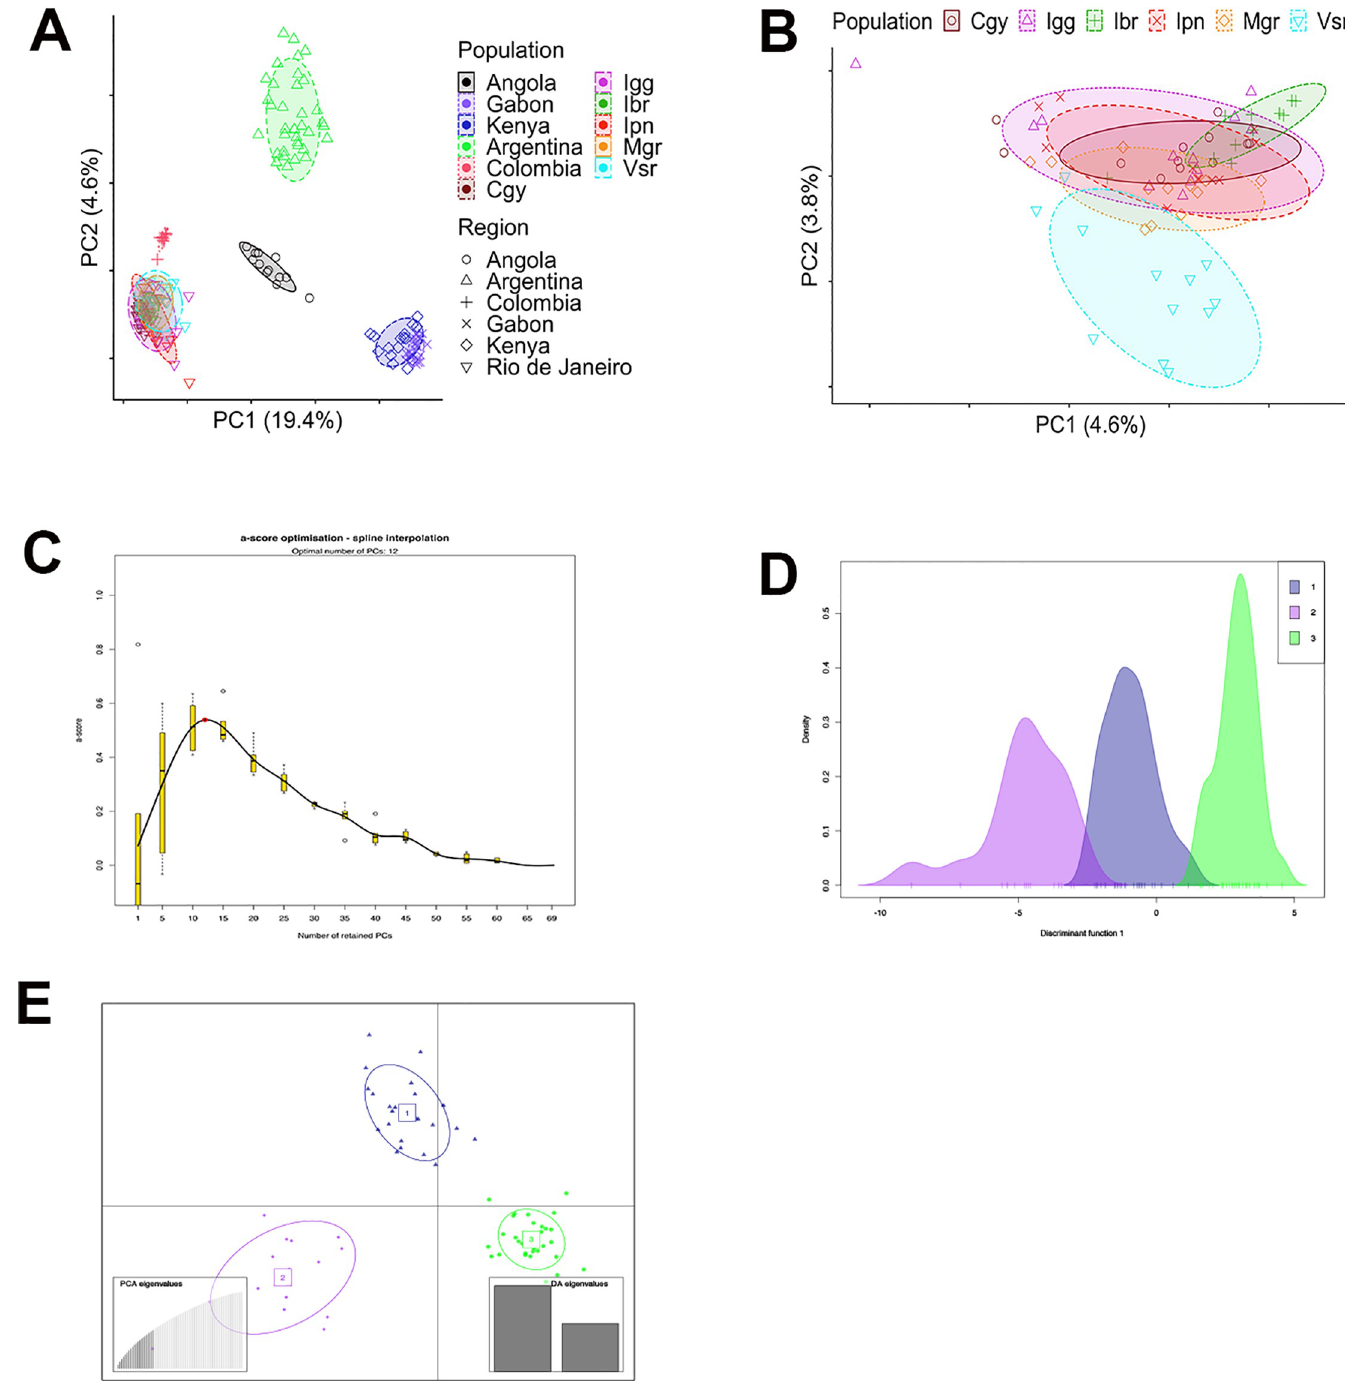
Fig 7. PCA plots showing the first two principal components (PCs). The numbers in the parentheses on the axes indicate the percentage of total variation explained by the PCs. The eclipses represent an 80% confidence level. A. Clustering of populations from Rio de Janeiro State with other populations from different countries. B. Clustering the populations from Rio de Janeiro State only. C. Ideal number of principal components used with DAPC. D. Discriminant function 1 showing three distinct genetic clusters in our data with minimal overlap. E. DAPC for our populations. The graph represents the individuals as dots and the groups as inertia ellipses. A bar plot of eigenvalues for the discriminant analysis (DA eigenvalues) at the inset at the right. The inset bars represent the number of discriminant functions retained in the calculations; we used the first two to generate the plot. On the left, a graph shows how many principal components we used.